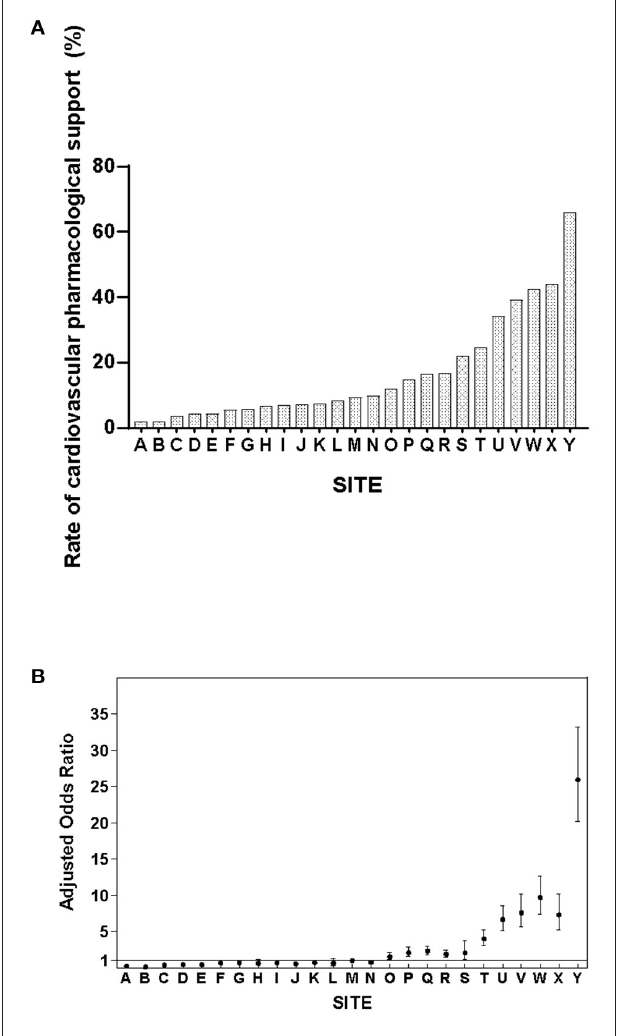
FIGURE 2 | (A) Variability in cardiovascular pharmacological support rates among Chinese NICUs. (B) Adjusted odds ratios of cardiovascular pharmacological support among Chinese NICUs. Site M served as the reference site as it has the median rate of cardiovascular pharmacological support. The y-axis represents the adjusted odds ratio after controlling for confounders in multivariate regression